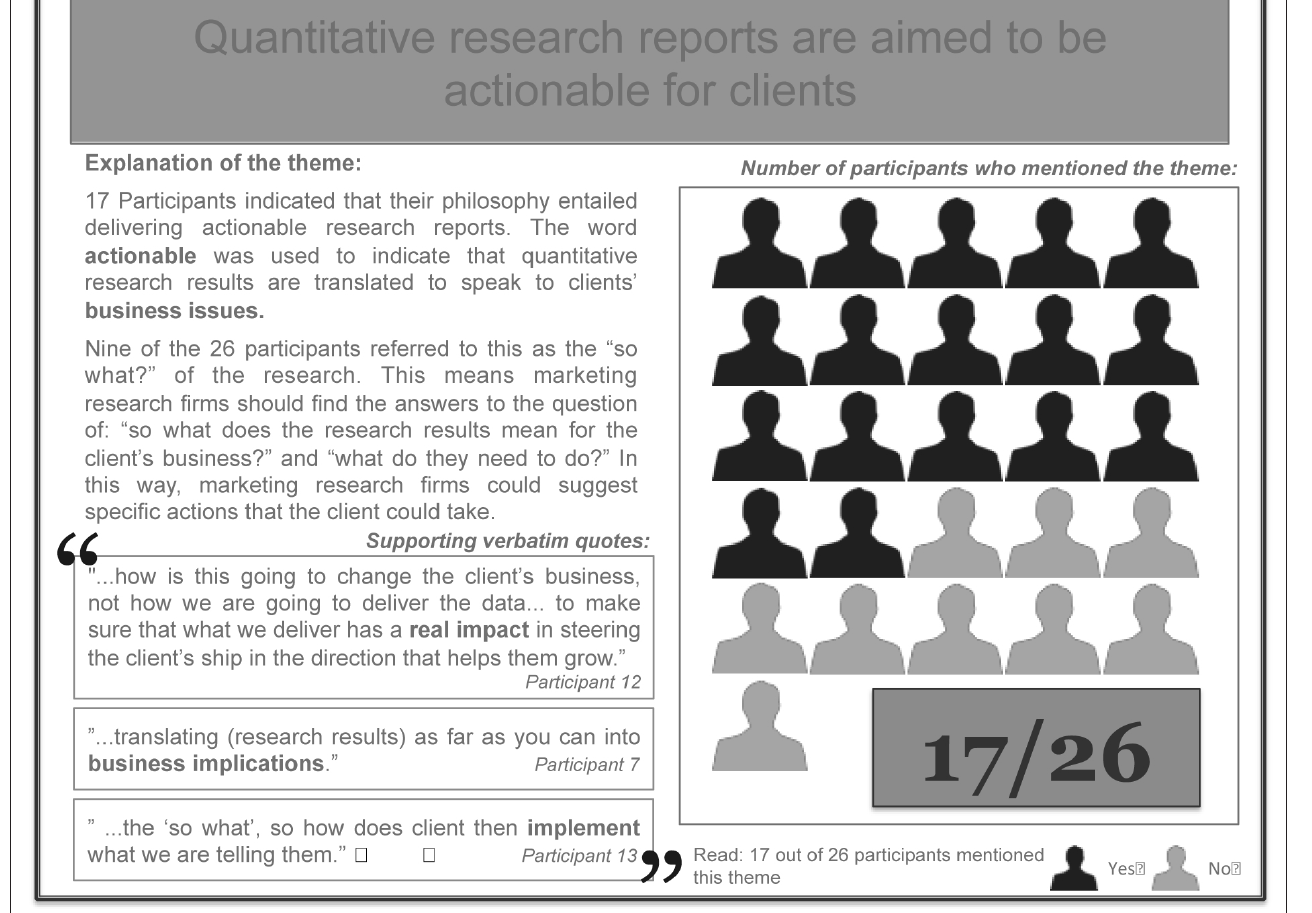
FIGURE 1: Participants’ view of quantitative